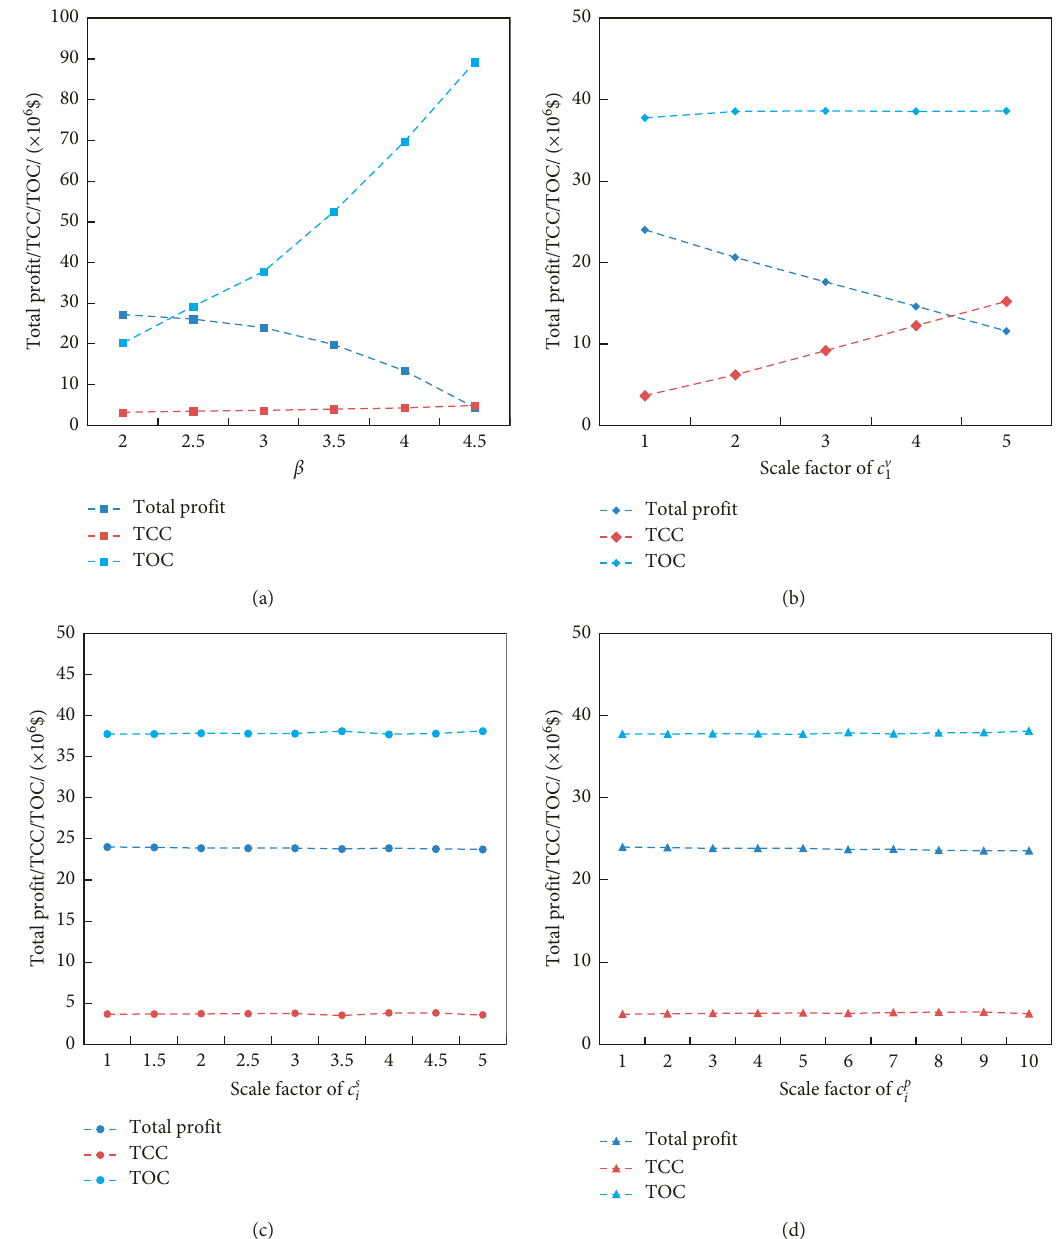
Figure 13: Sensitivity of model parameters on system